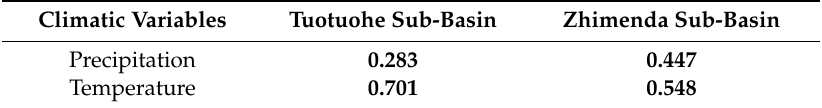
Table 7. Correlation coe ffi cient between annual streamflow and annual areally averaged precipitation andtemperatureforeachsub-basin.